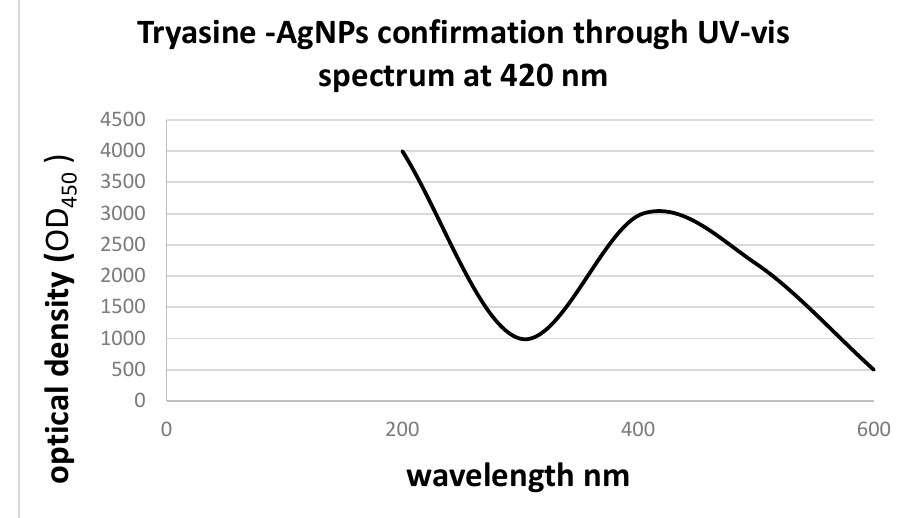
Figure 2. Absorption had shown silver nanoparticles surface plasmon resonance at 420 nm.